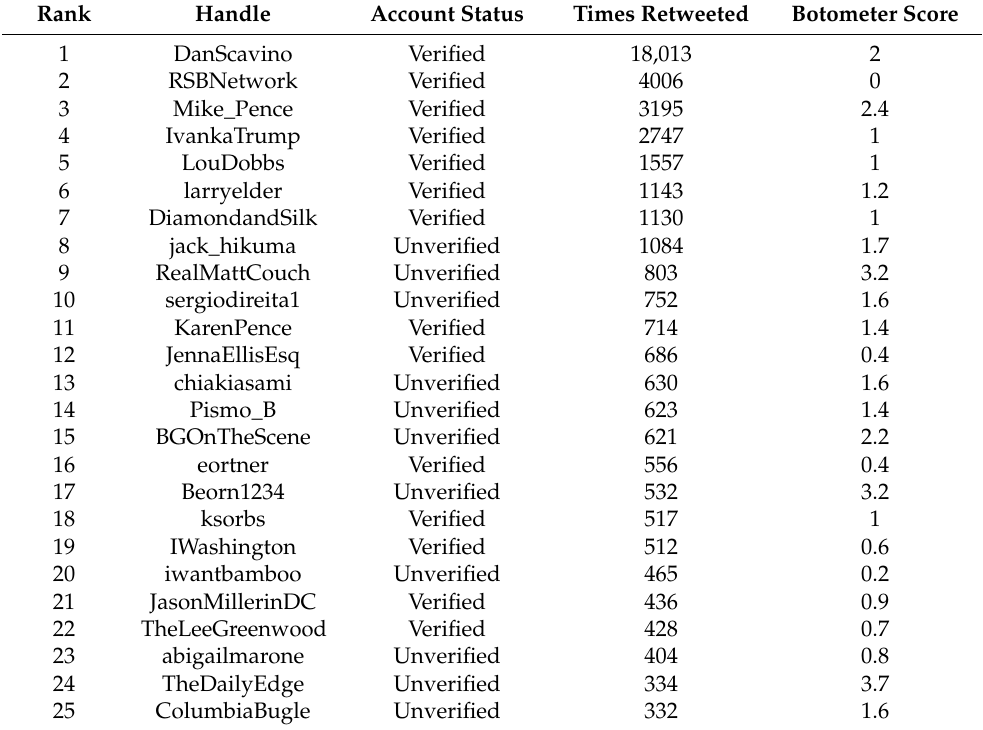
Table 3. The 25 most retweeted